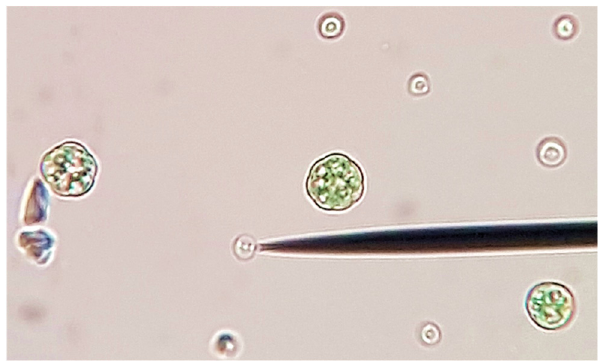
Figure 1. Spore formation in Galdieria phlegrea ACUF 784.3 (original photo).